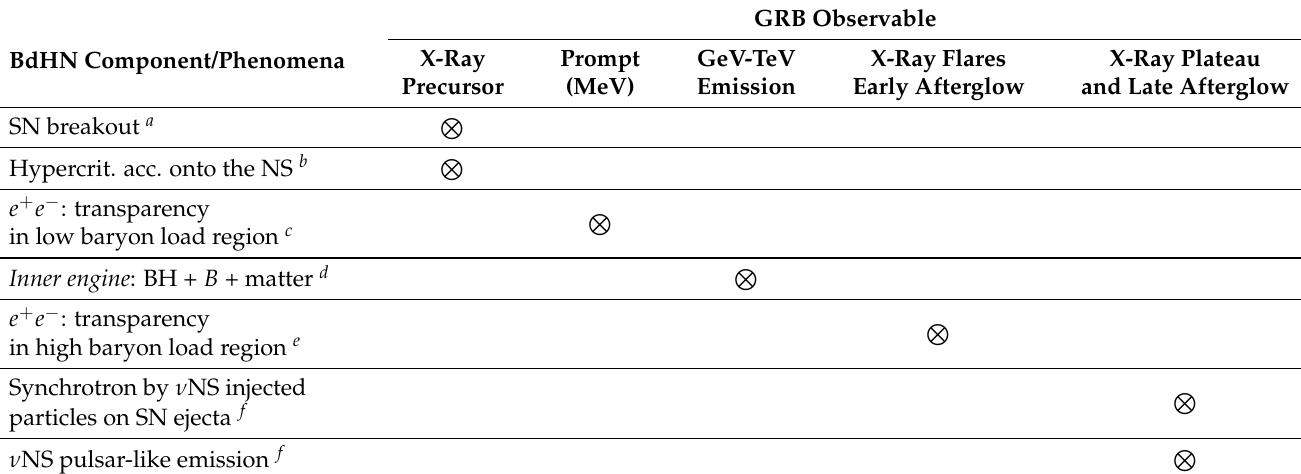
Table 1. Summary of the gamma-ray burst (GRB) observables associated with each BdHN I component and physical phenomenon. Adapted from Table 1 in [61] with the permission of the authors. References in the table: a [60], b